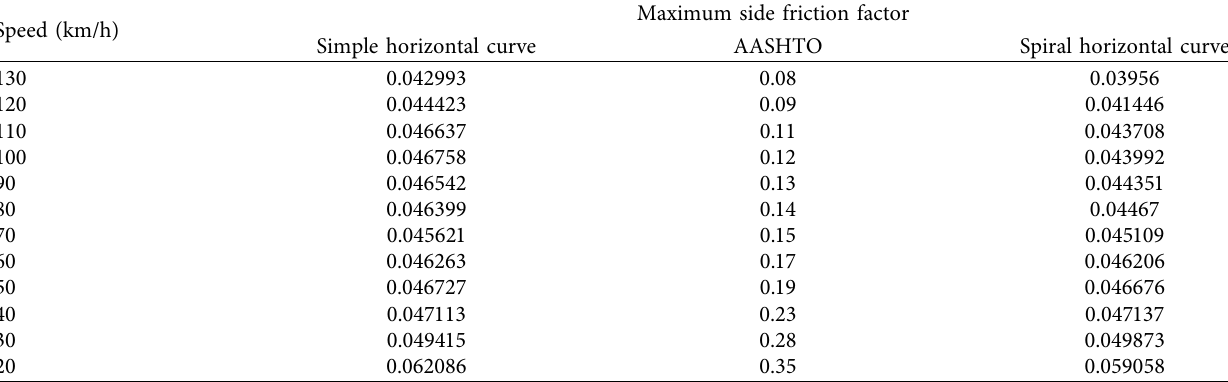
Table 7: Comparison of the maximum side friction factor for a truck between simple and spiral horizontal curves and AASHTO rec- ommended values at a radius of 1.3 R.